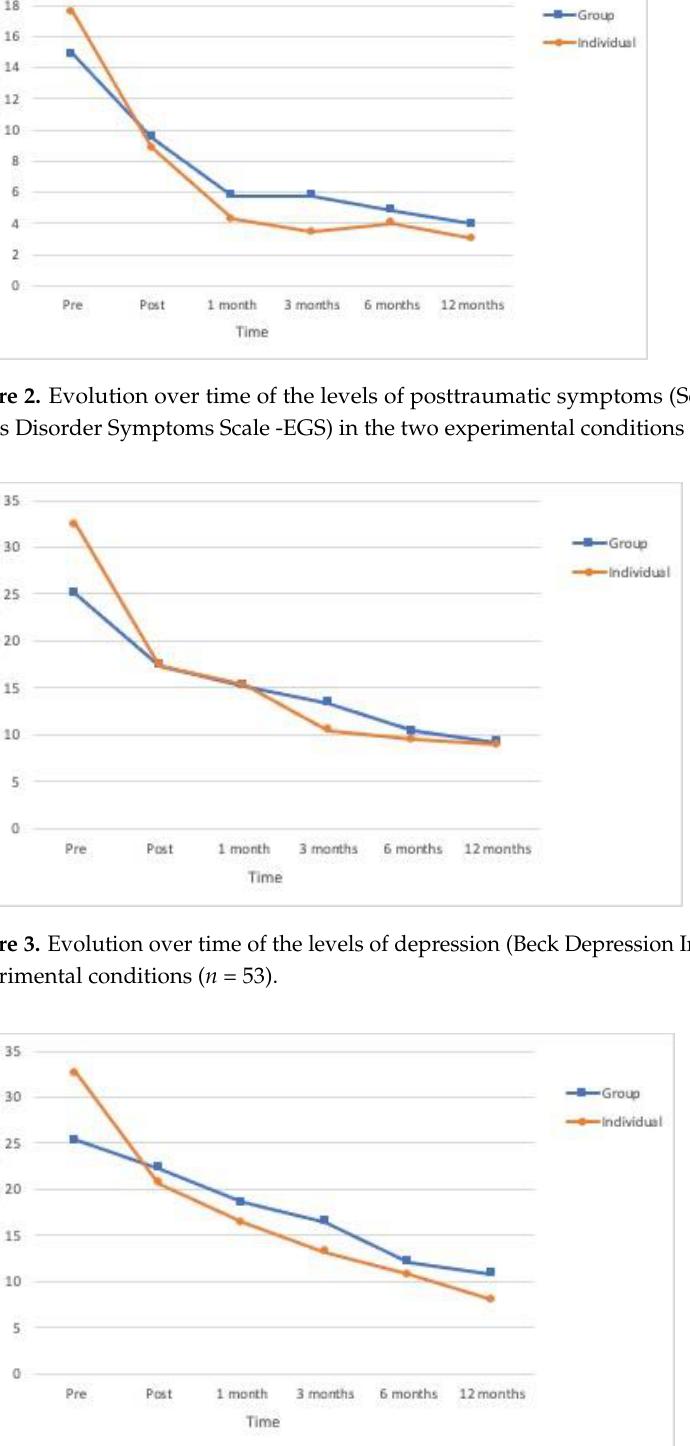
Figure 4. Evolution over time of the levels of anxiety (Beck Anxiety Inventory-BAI) in the two experimental conditions ( n = 53).